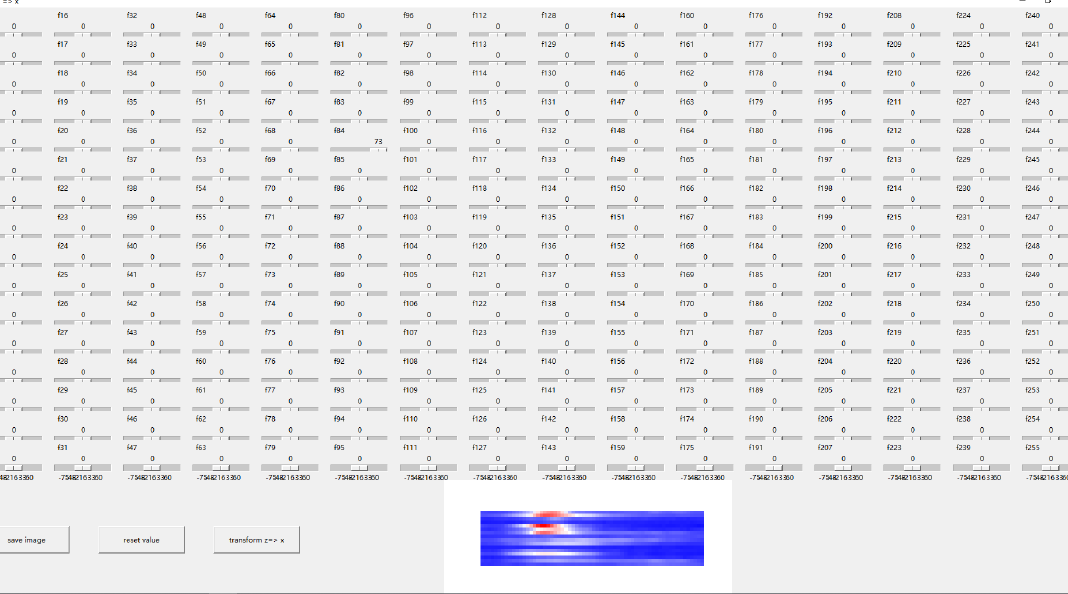
Figure A3. A GUI for interacting with the proposed approach. The fi ; i = 0 ∼ 255 denotes the i + 1 − th dimension of the factorized feature. The transform button transforms the current feature to the sEMG linear envelope and shows the result on the canvas at the bottom. The reset button is used to save the canvas. The reset button is used to set all the dimensions of the feature to